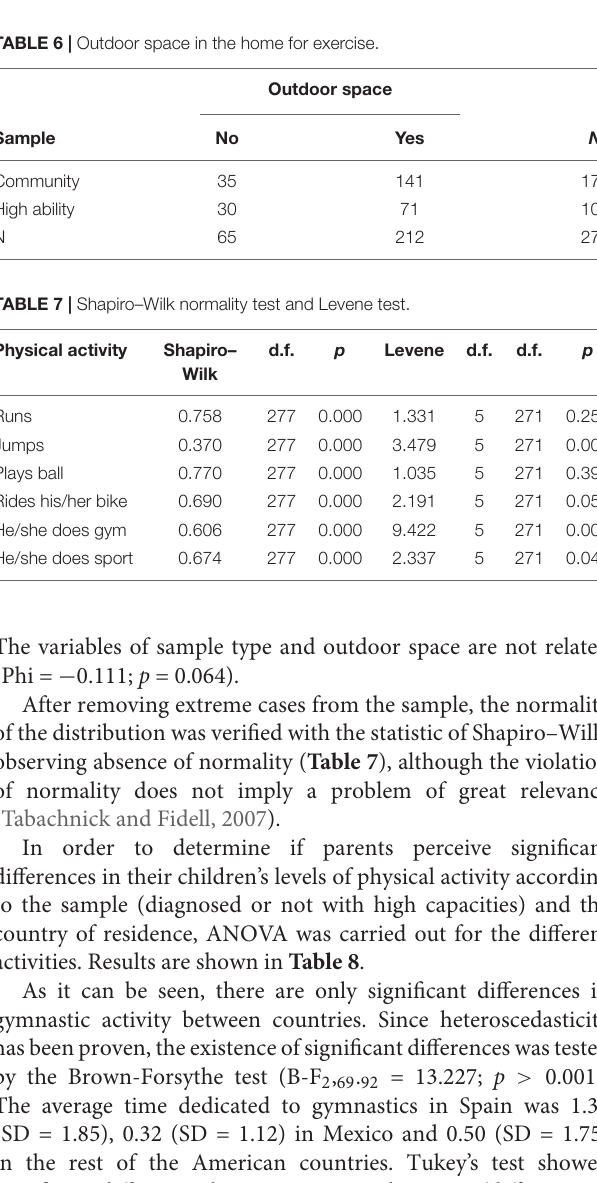
TABLE 4 | Shapiro–Wilk normality test and Levene test.